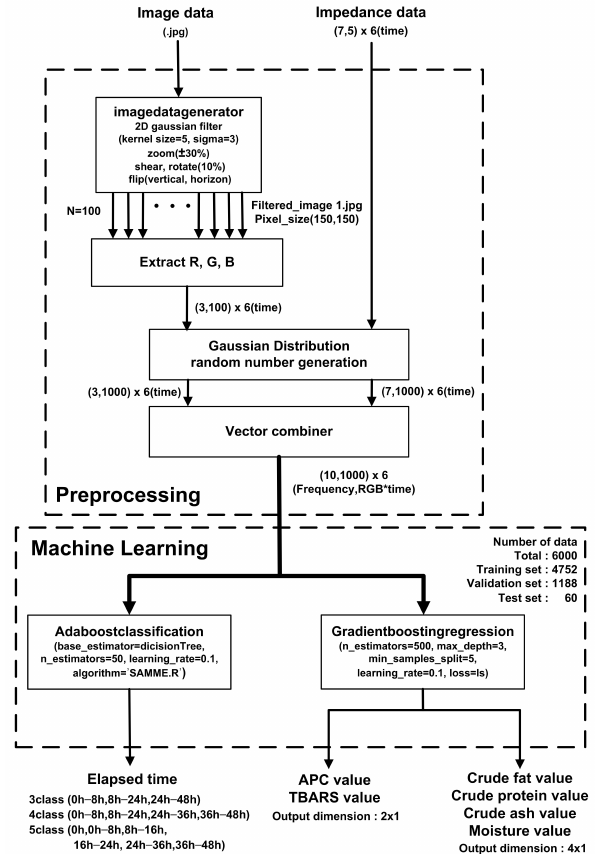
Figure 10. Utilization of EIS and image classification with preprocessing and AdaBoost classification and gradient boosting regression machine learning